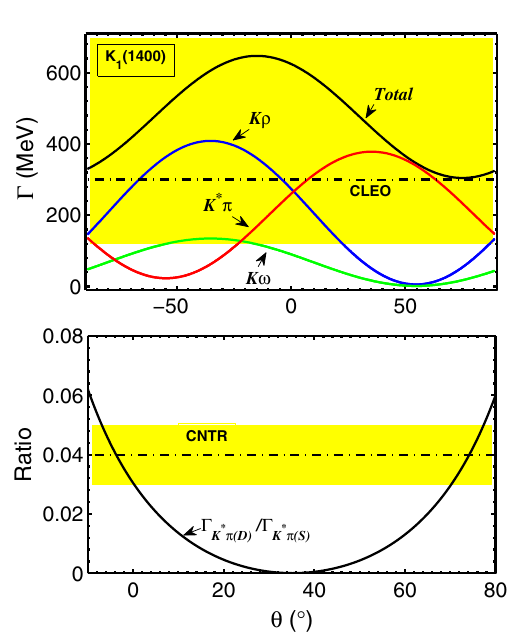
Fig. 3 θ 1 P dependence of the partial, the total decay widths and ratio